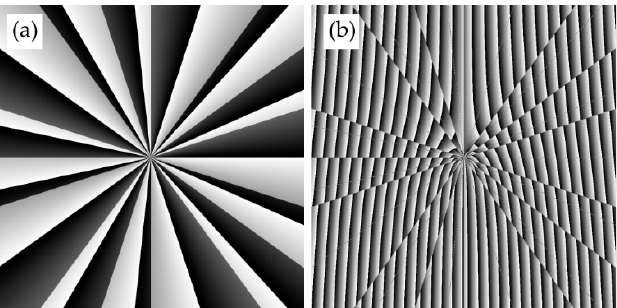
Figure 6. The phase of the light field (33) with n = 3, k = 0, m = 5, a = 1 ( a ) and the grayscale phase mask with a carrier spatial frequency used in the SLM ( b ).